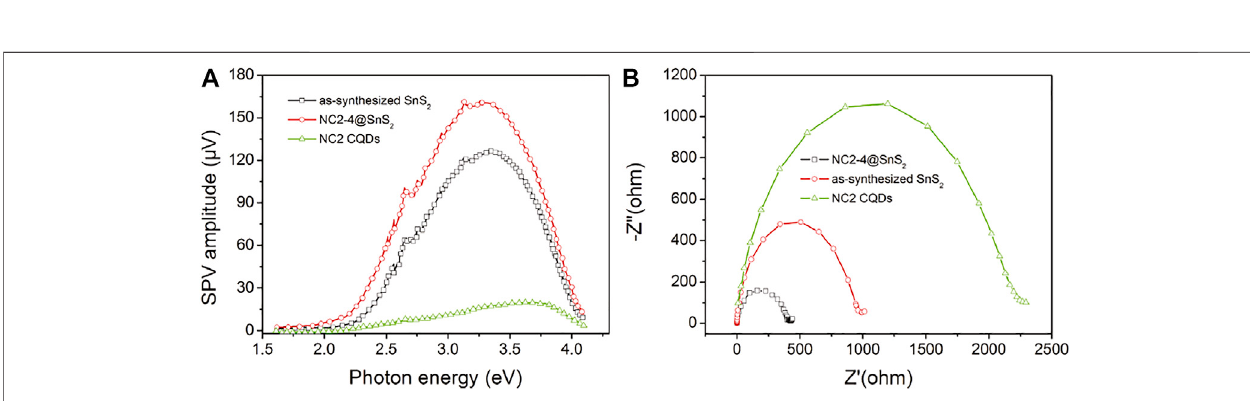
Frontiers in Chemistry |